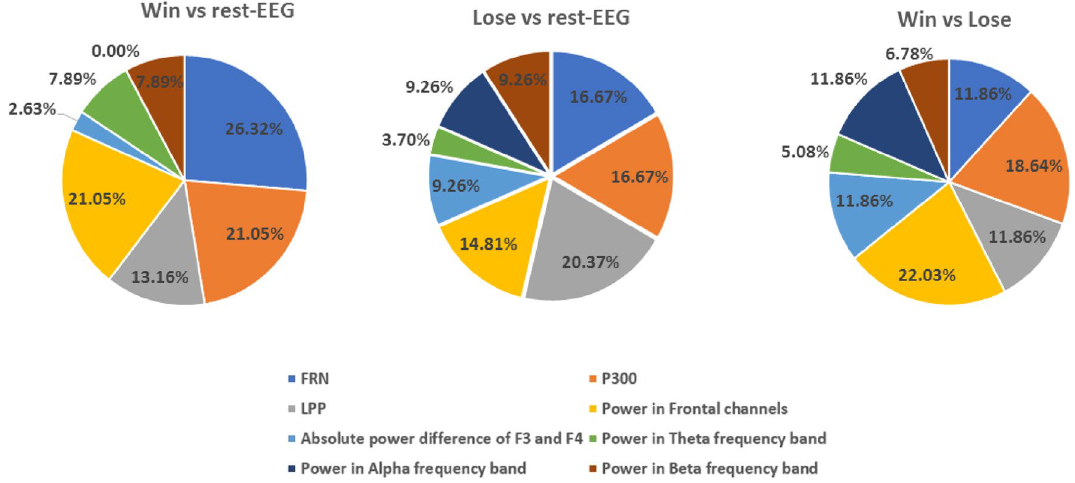
Figure 1. The percentage of the selected features for each classification